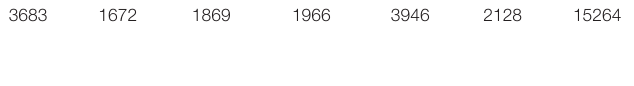
TABLE 1 | Emblem class: frequency of items in annotation and in